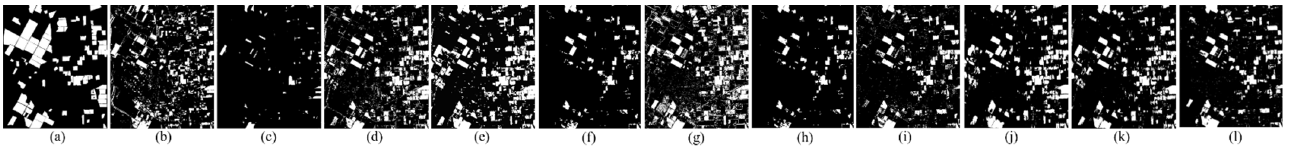
Figure 7. Binary detection results in the River dataset: ( a ) ground truth, ( b ) LSCD, ( c ) ASCD, ( d ) HOSVD, ( e ) TDRD, ( f ) PCANet, ( g ) DSFANet, ( h ) HI-DRL, ( i ) SSTN, ( j ) UTT-SVD, ( k ) UTT-noSVD, and ( l ) STT.